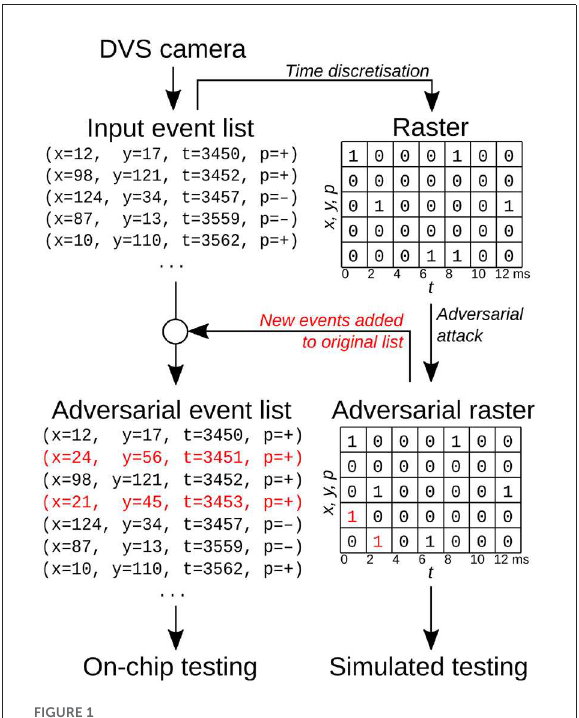
FIGURE1 Schematic of the attack procedure on Dynamic Vision Sensor